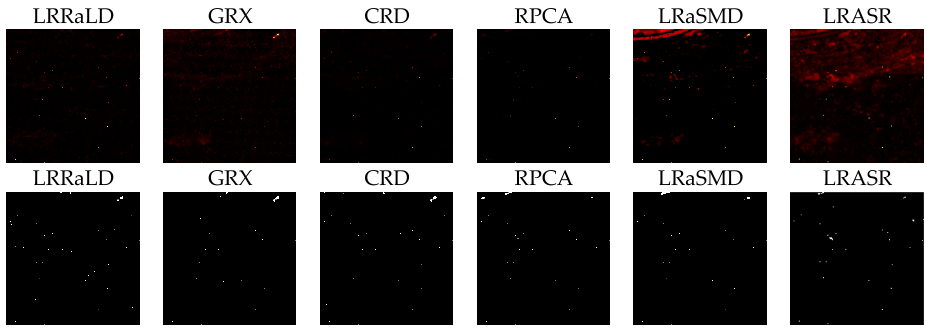
Figure 9. Detection results under simple background using different methods: ( top ) 2-D display; and ( bottom ) binary results when PFA equals 0.001.